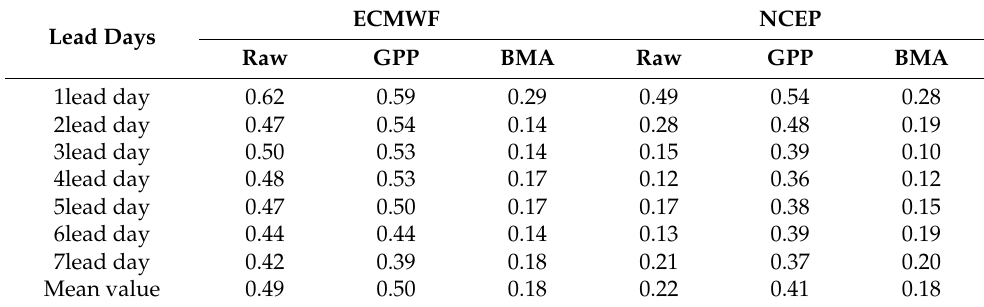
Table 2. CRPSS values for ensemble streamflow simulated by raw and postprocessed ECMWF and NCEP at 1~7 lead days during the 2017 period. ECMWF Lead Days